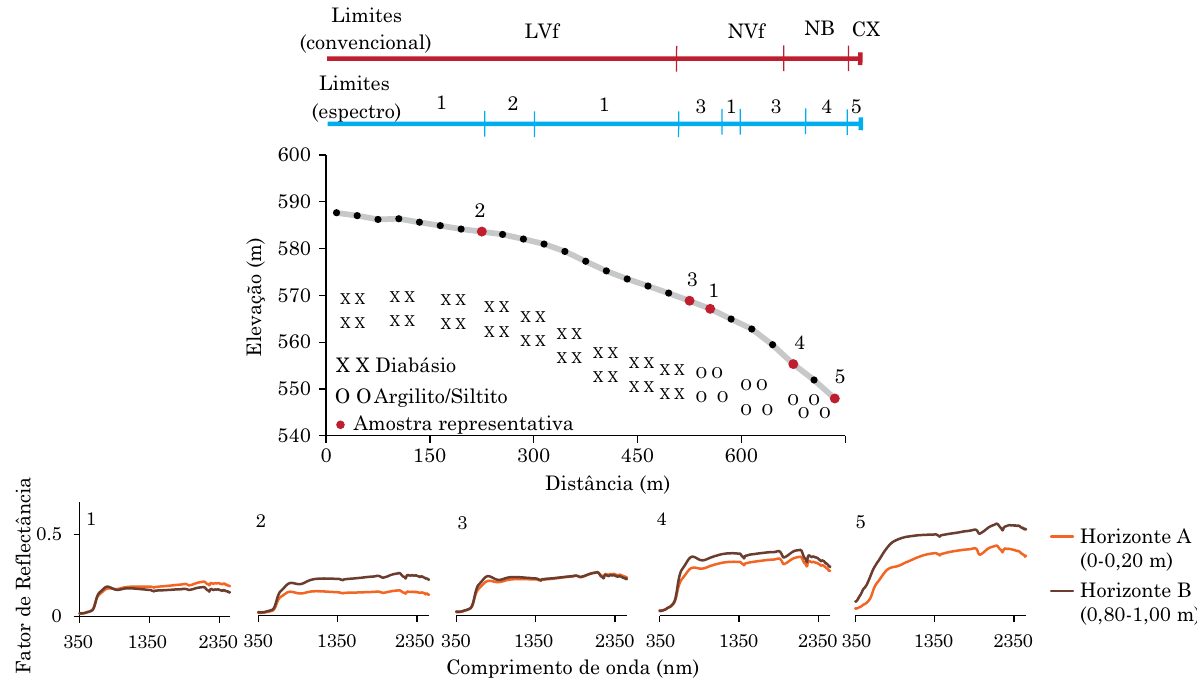
Figura 3. topossequência B e limites de classes de solos determinados por métodos convencional e espectral. os pontos 1, 2, 3, 4 e 5 correspondem às amostras representativas às suas unidades espectrais (pontos em vermelho), apresentando as curvas espectrais dos horizontes a e